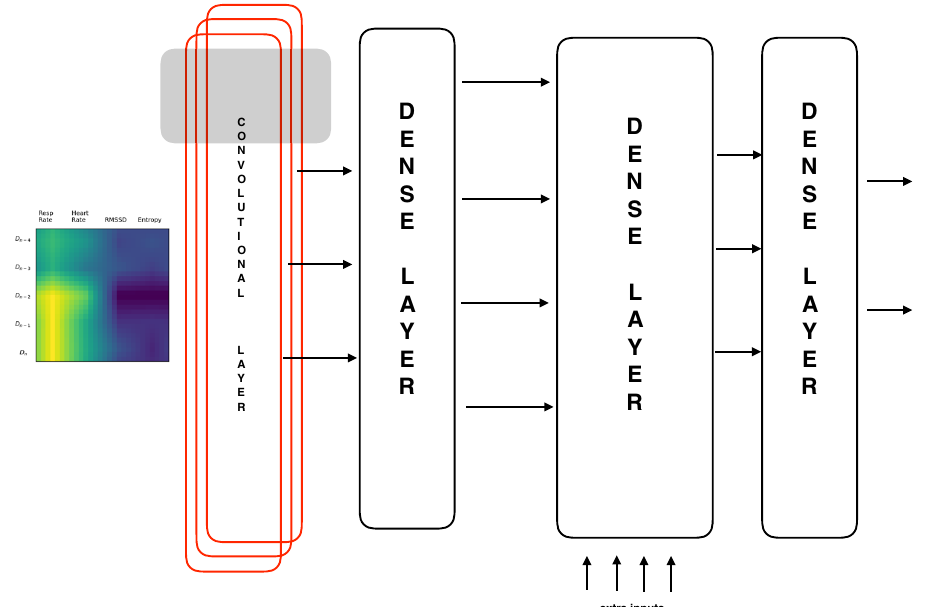
Fig. 6 The neural network architecture. The nocturnal respiration rate, heart rate, RMSSD, and entropy for day D n along with the previous 4 days data are Z -scaled, arranged in the form of a 5 × 4 matrix and rescaled to 28 × 28 × 1. This image is fed to a 1-dim. convolutional layer with m fi lters. The fi rst dense layer reduces these m features to a smaller number of N 1 features which are concatenated with an array of external inputs such as age, gender, BMI, etc. The last dense layer leads to a softmax fi lter.